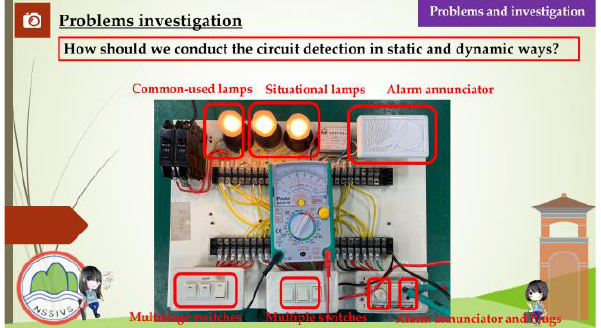
Figure 2. Competency-based instructional materials used in this research. These require situation analysis skills.